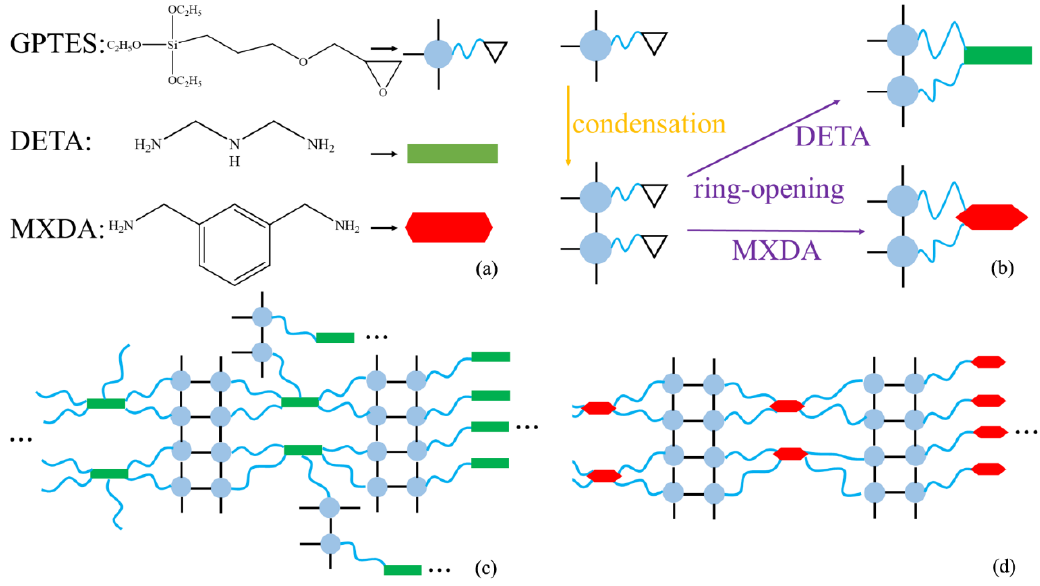
Figure 1. Schematic illustration of the OSER coating. ( a ) Simplification of reactant. ( b ) Reaction process. ( c ) DETA-OSER network. ( d ) MXDA-OSER network.